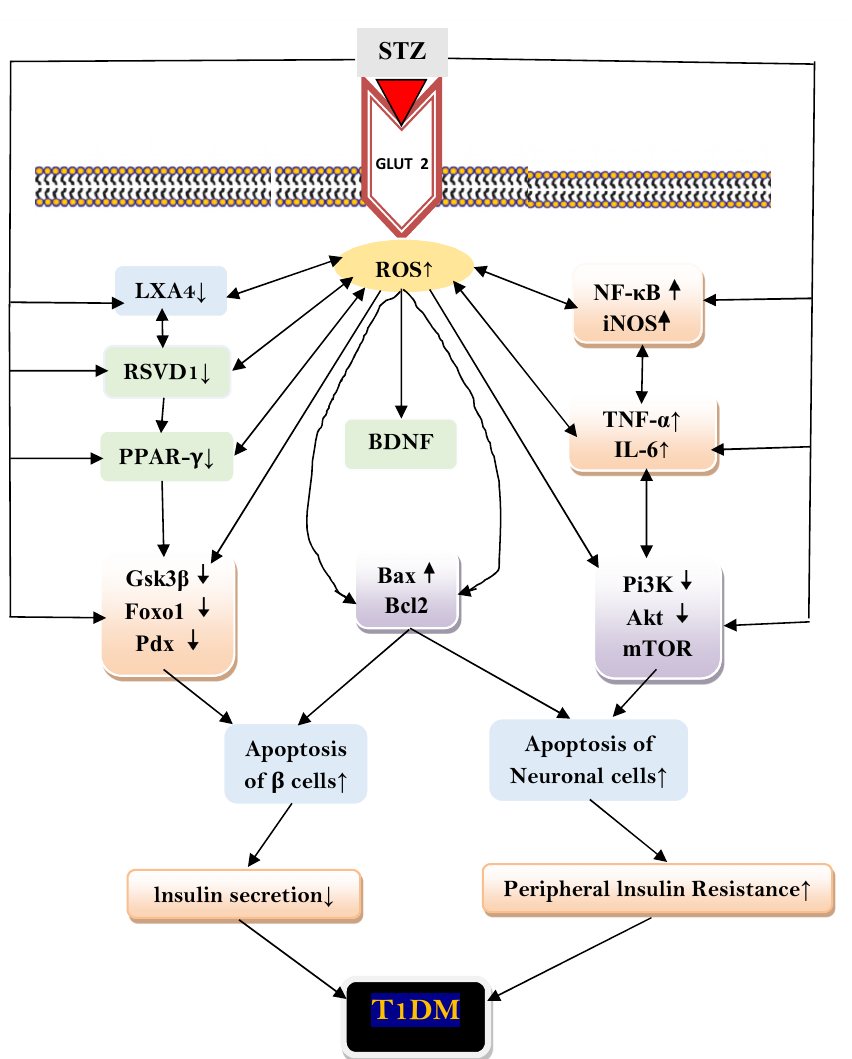
Figure 4. Scheme showing potential mechanism(s) by which STZ could induce T1DM. STZ enters the Figure 4. pancreatic beta cell by binding to GLUT-2 receptors. STZ enhances the generation of ROS (reactive oxygen species) at least in part by activating NADPH oxidase, by enhancing the expression of NF-kB that, in turn, enhances the production of IL-6 and TNF- α . Both these cytokines can also enhance the generation of ROS. Excess ROS generated also includes iNOS (inducible nitric oxide species). ROS and its resultant lipid peroxides can act on Bax and Bcl2, PI3K, Akt and mTOR, PPAR γ , Gsk3 β , and Pdx and alter their expression in such a way that apoptosis of pancreatic β cells occurs and regeneration of β cells is interfered with leading to decreased insulin production and onset of type 1 DM. STZ either acting directly or through ROS may reduce LXA4 and RSVD1 (also depicted as RVD1 in the text) formation or its half-life that results in their low plasma levels in type 1 DM. Low concentrations of LXA4 and RvD1 and increased Bax and decreased Bcl2 results in apoptosis of pancreatic β cells and development of type 1 DM. LXA4 and RSVD1 have anti-inflammatory actions and thus, decrease peripheral insulin resistance. Decrease in the plasma concentrations of LXA4 and RSVD1 results in an increase in IL-6 and TNF- α levels due to the absence of their (LXA4 and RVSD1) feedback negative control on cytokines. Both IL-6 and TNF- α can also cause increase in peripheral insulin resistance due to their pro-inflammatory actions. The cytoprotective actions of LXA4 and RSVD1 can protect β cells from the cytotoxic action of STZ by suppressing the generation of ROS and inhibiting the formation of IL-6 and TNF- α . RSVD1 enhances LXA4 formation. Thus, there is a close interaction among various lipids. In light of these evidence methods designed to enhance the formation of LXA4/RSVD1, there may form a new therapeutic strategy to prevent type1